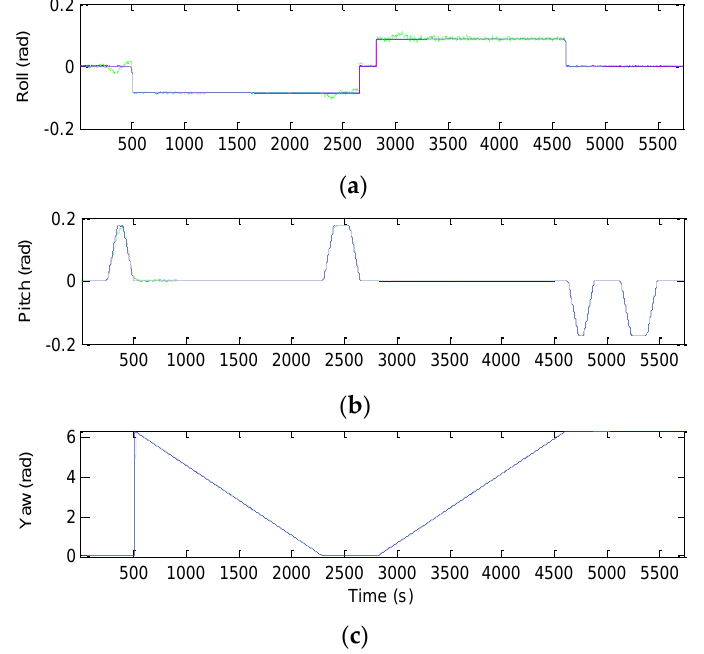
Figure 14. Comparison of Euler angle estimation results: CKF (in green) versus FACKF (in blue)—Scenario 2. ( a ) Roll angle; ( b ) Pitch angle; ( c ) Yaw angle.